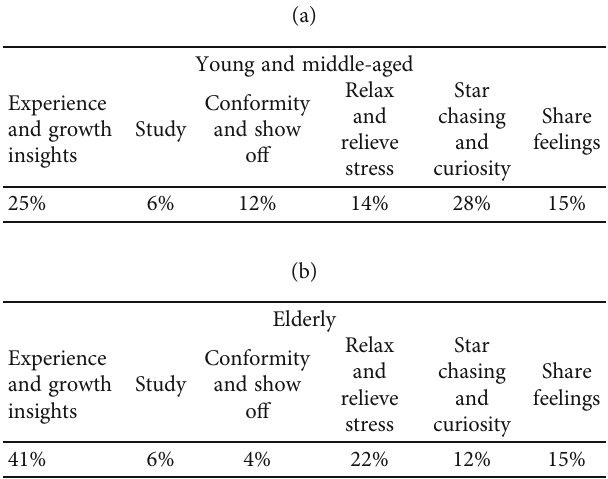
Table 1: A survey on the tourism motivation of middle-aged, young and old people.